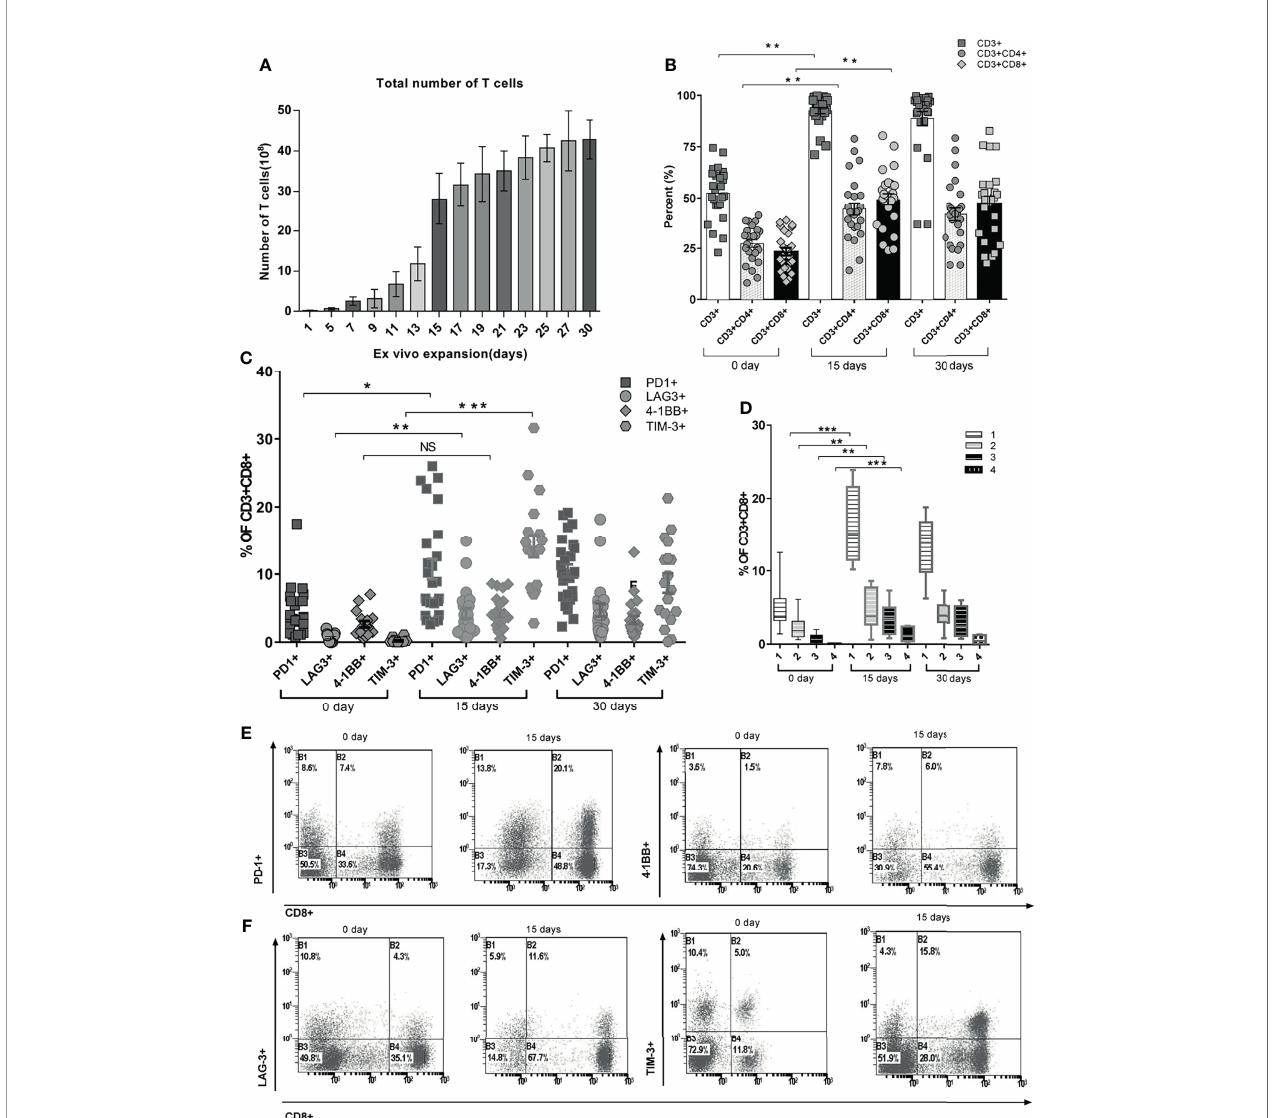
FIGURE 2 | Quantitation of various phenotypic T-cell proportions over time during the ex vivo PBMC expansion. (A) Total number of expanded T cells daily from day 0 to day 30. Each color represents T-cell assembly from day to day. (B) Hierarchic phenotypic percentage of CD3 + , CD3 + CD4 + , and CD3 + CD8 + recorded at day 0, day 15, and day 30. Each actual fraction of T-cell subsets was recorded and shown as mean ± SEM. (C) Functional stimulator and suppressor T-cell subsets of each individual were strati fi ed during the continuous expansion at day 1, day 15, and day 30. (D) Co-expression percentage of PD-1, LAG-3, TIM-3, and 4-1BB in CD8 + PBMCs. The frequency of cells expressing either single or multiple markers above termed as 1, 2, 3, or 4 is shown. Bars represent maximum, minimum, and mean values. (E) Fractioned sorting distributions of co-expression percentage of PD-1 and 4-1BB on CD8 + PBMCs through cytometric analysis (a representative patient is shown). (F) Fractioned sorting distributions of co-expression percentage of LAG-3 and TIM-3 on CD8 + PBMCs through cytometric analysis (a representative patient is shown). *p < 0.05, **p < 0.01, ***p < 0.001, Mann – Whitney test. PBMC, peripheral blood mononuclear